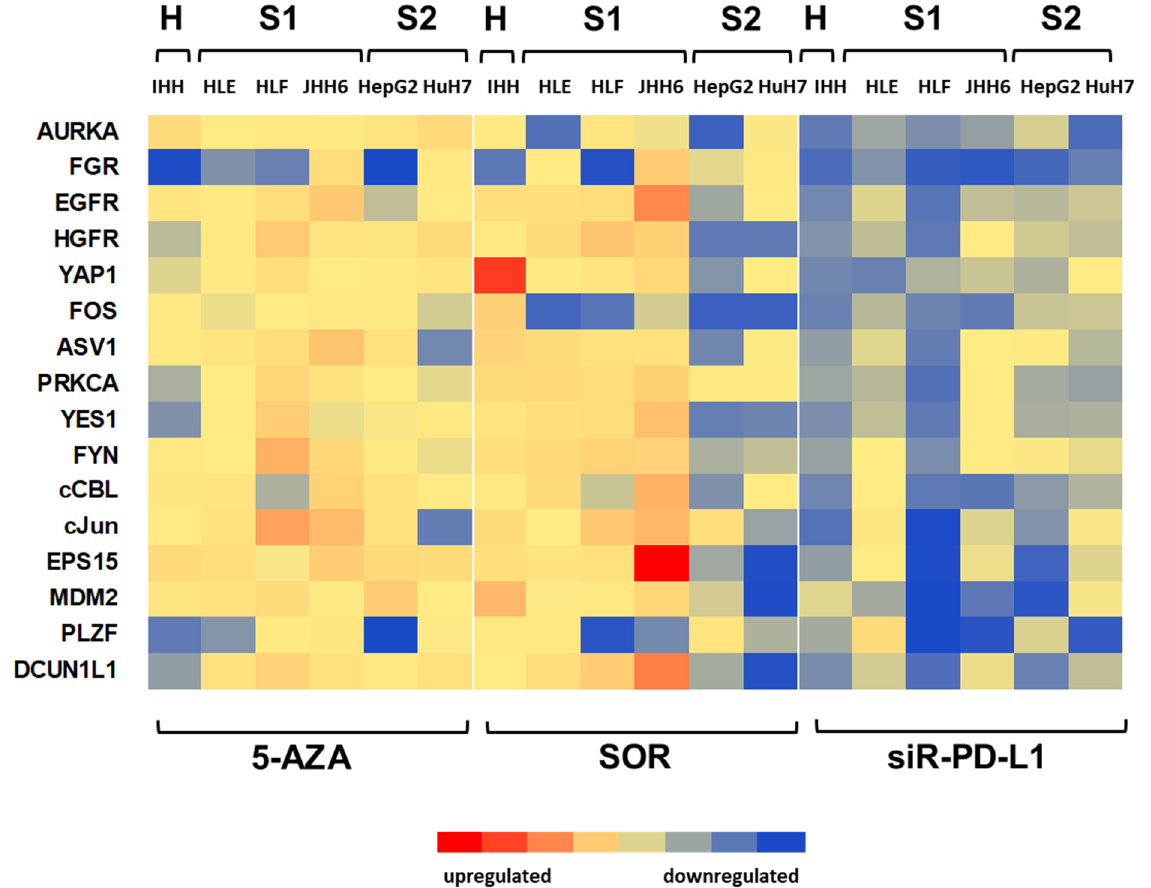
Figure 4. Dysregulation of targets mRNA expressions in liver cancer cell lines after various treatments. Heat map indicates the up-regulation and down-regulation of the markers after treatment with 5 µM 5-AZA, 50 µM SOR and 20 nM siR-PD-L1.